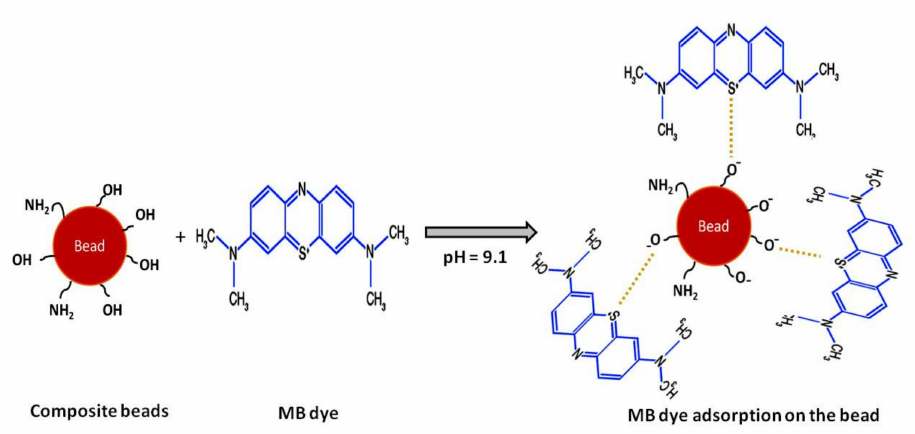
Figure 7. Proposed adsorption mechanism of methylene blue dye on composite